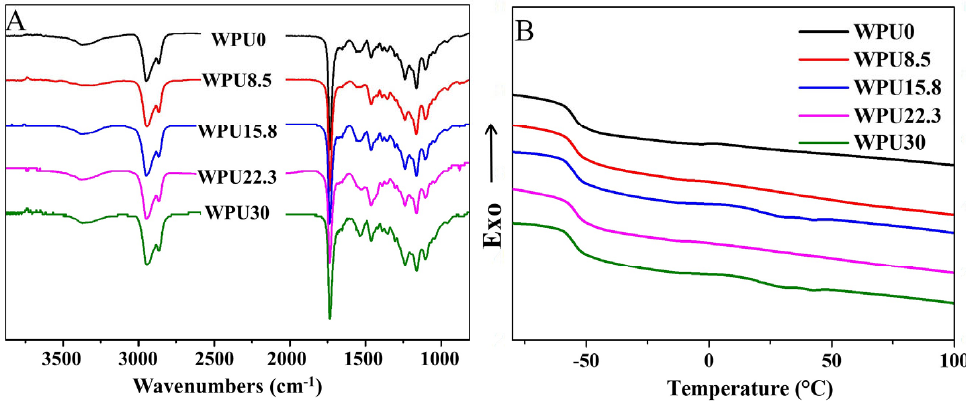
Figure 2. ( A ) The transmission FTIR spectra of WPUn samples. ( B ) DSC thermograms of WPUn samples (second heating).